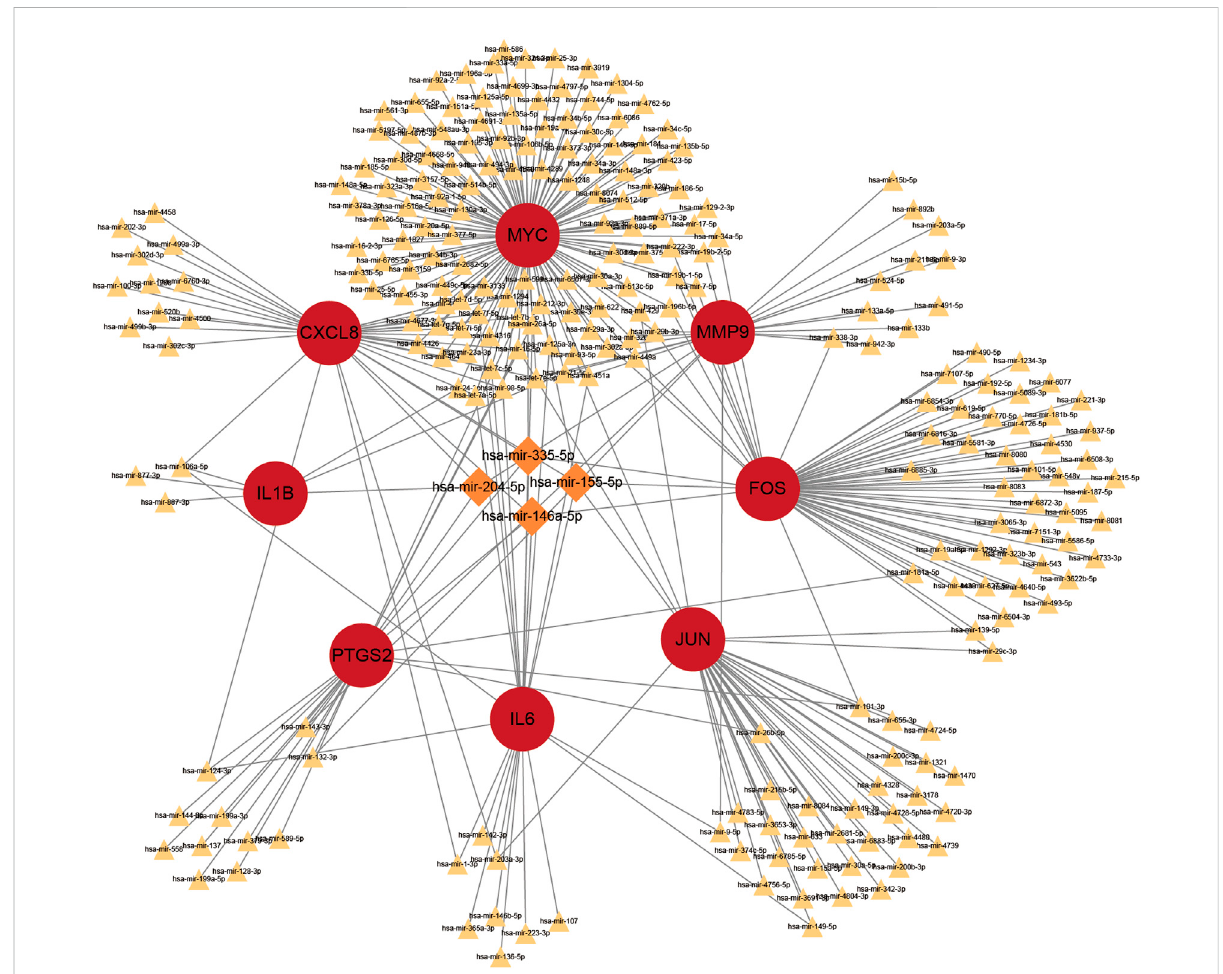
FIGURE 10 The top 4 hub genes in the integrated miRNA-gene network. The red circles indicate these hub genes. MiRNAs with linkage to more central genes are highlighted exclusively with larger orange diamonds, and the rest are indicated with smaller yellowish